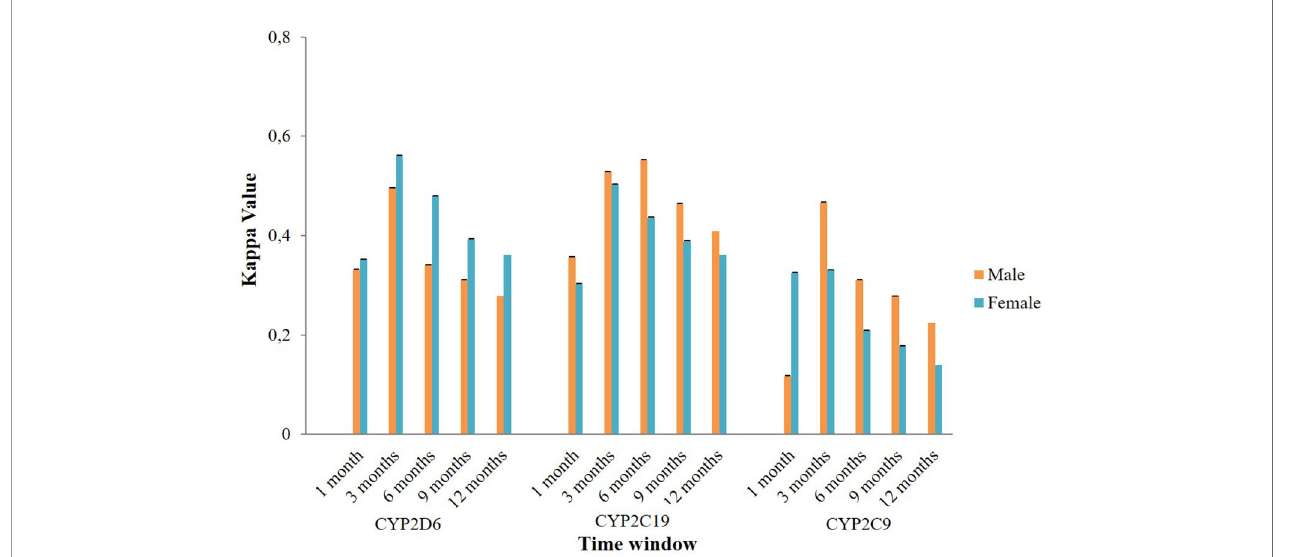
FIGURE 4 | The effect of sex on the agreement between the Lifelines cohort and the IADB.nl database.